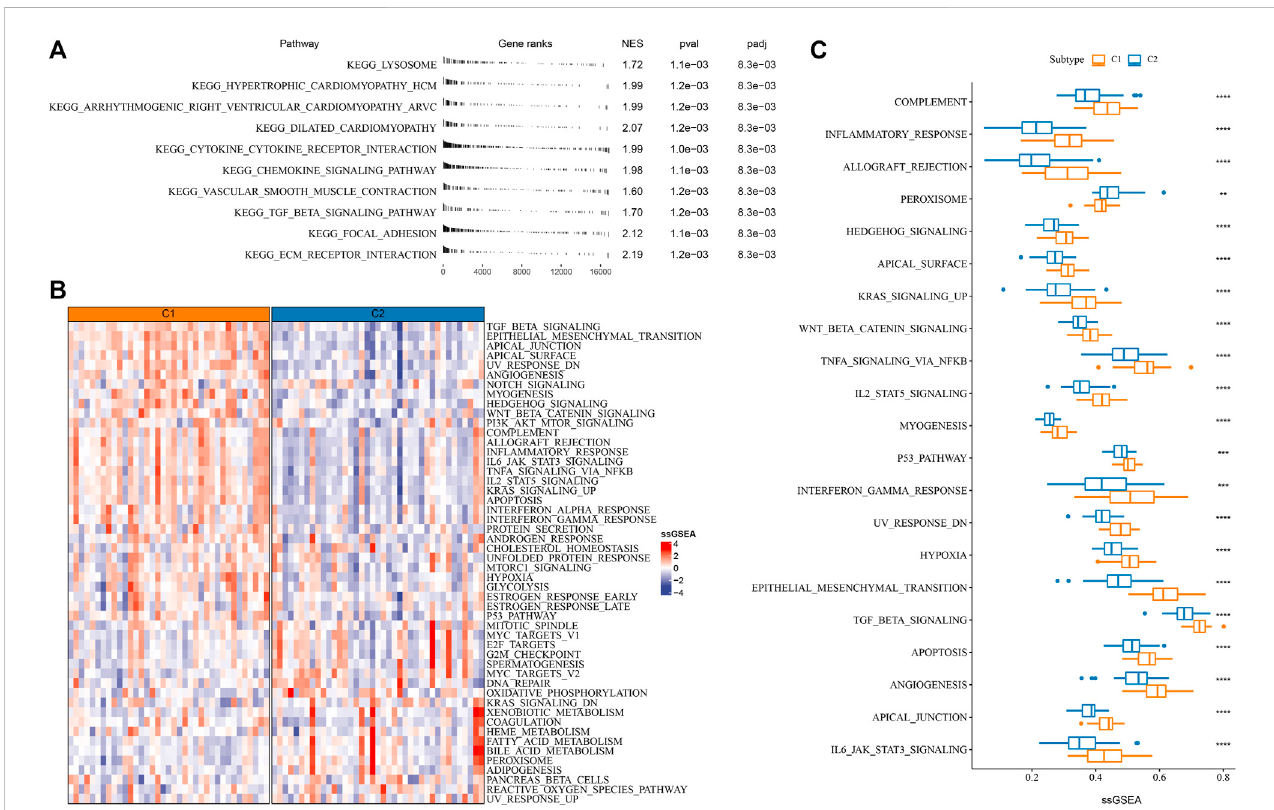
FIGURE 2 Enrichment of functional pathways in C1 and C2 of E-MTAB-6389 cohort. (A) GSEA results displaying signi fi cantly enriched KEGG pathways of C1. (B) Heatmap of the top 50 enriched pathways in C1 and C2. (C) A total of 21 pathways differentially enriched between C1 and C2. Wilcoxon test was conducted. ** p < 0.01, *** p < 0.001, **** p <